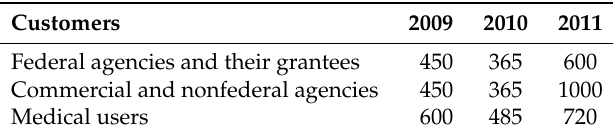
Table 2. Allocated Helium-3 prices per liter (in dollar)